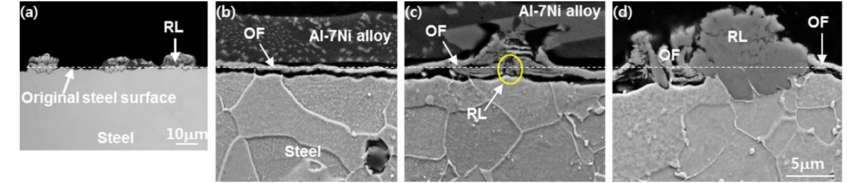
Figure 1. Appearance of various reaction layers formed on the surface of the specimen hot dipped in Al–7Ni (wt %) for 10 s. ( a ) Light microscope microstructure. ( b – d ) SEM images: ( b ) the oxide film (OF) formed on the surface; ( c ) the decomposition of the oxide film, followed by nucleation of the reaction layer (RL); and ( d ) the formation of